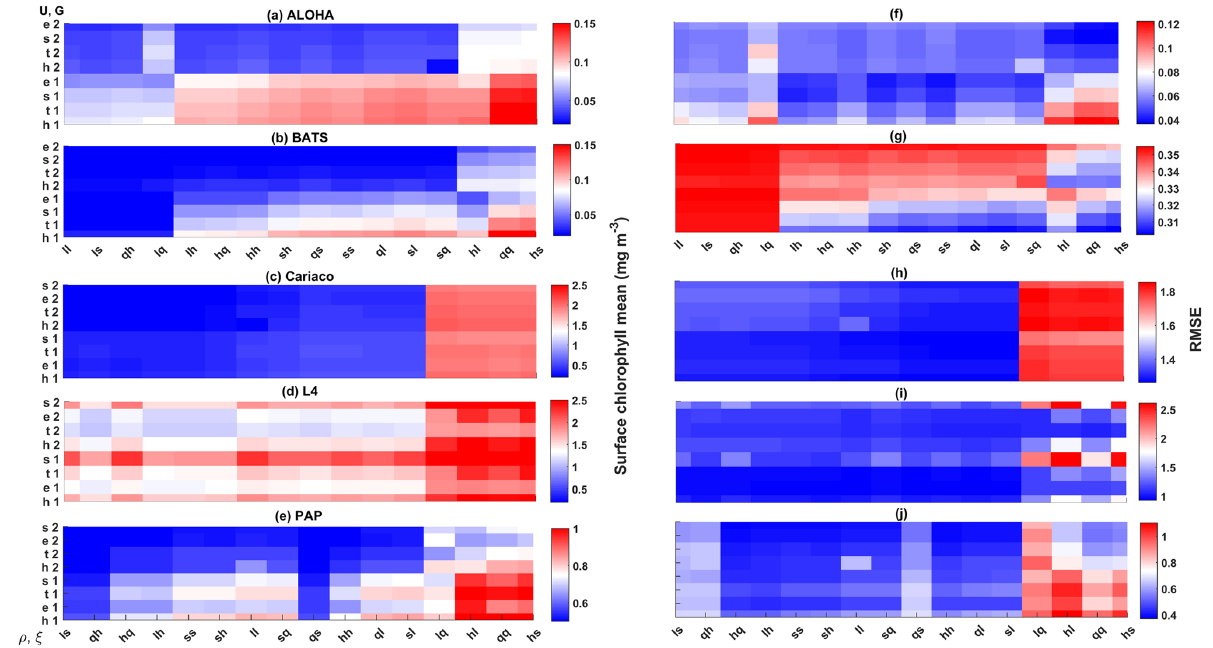
Figure 12. The 10-year mean and RMSE of surface chlorophyll (mgm − 3 ) at five stations from all ensemble members. The first column (pan- els a–e ) shows surface chlorophyll mean and RMSEs are shown in the second column (panels f–j ). Concentrations and RMSEs in each panel are arranged from the lowest chlorophyll mean to the highest, depending on the oceanographic regions. For station PAP, the sequence is sorted based on coastal station. The y axis shows combinations of uptake ( U h , U s , U e , and U t ) and grazing ( G 1 and G 2 ), and the x axis shows combinations of phytoplankton ( ρ ) and zooplankton ( ξ )